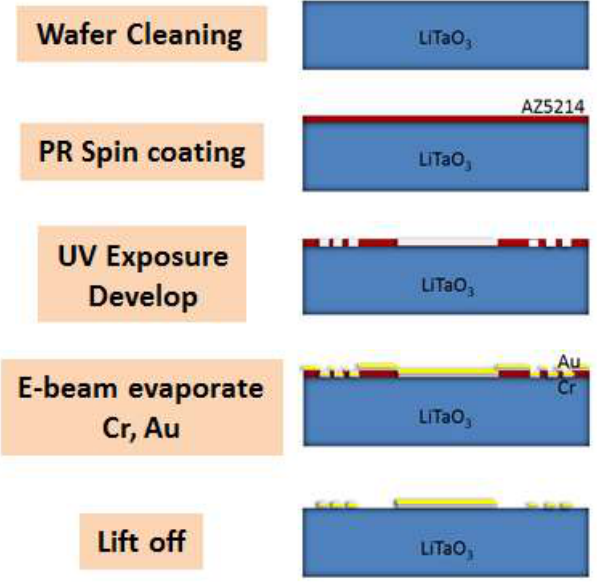
Figure 1. Fabrication of SH-SAW chips.